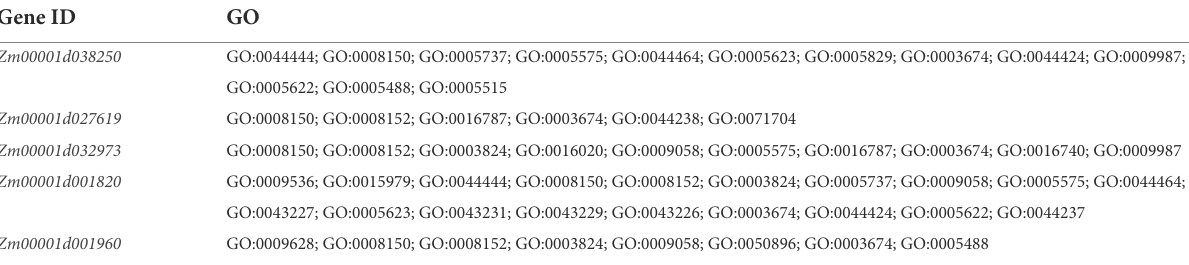
TABLE 5 GO analysis of candidate genes related to the RNA-seq result.